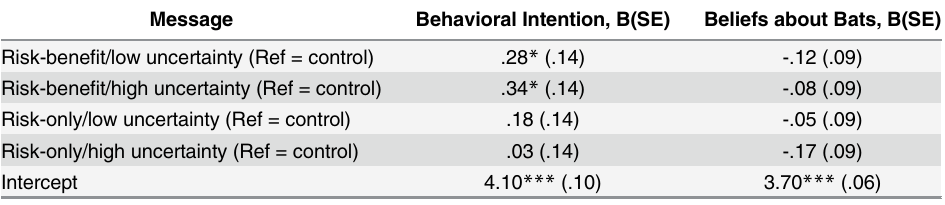
Table 2. Message effects on intention to tell a park ranger about a strangely behaving bat and beliefs about bats.